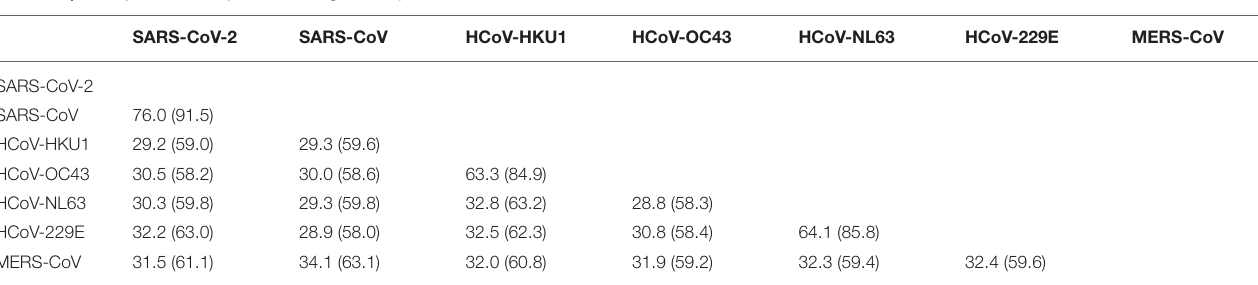
TABLE 2 | Identity and similarity score among virus S proteins.